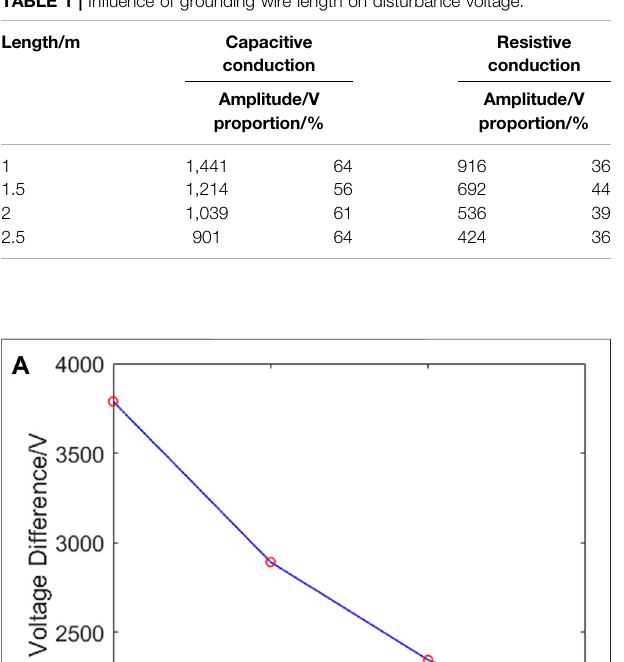
TABLE 1 | In fl uence of grounding wire length on disturbance voltage.